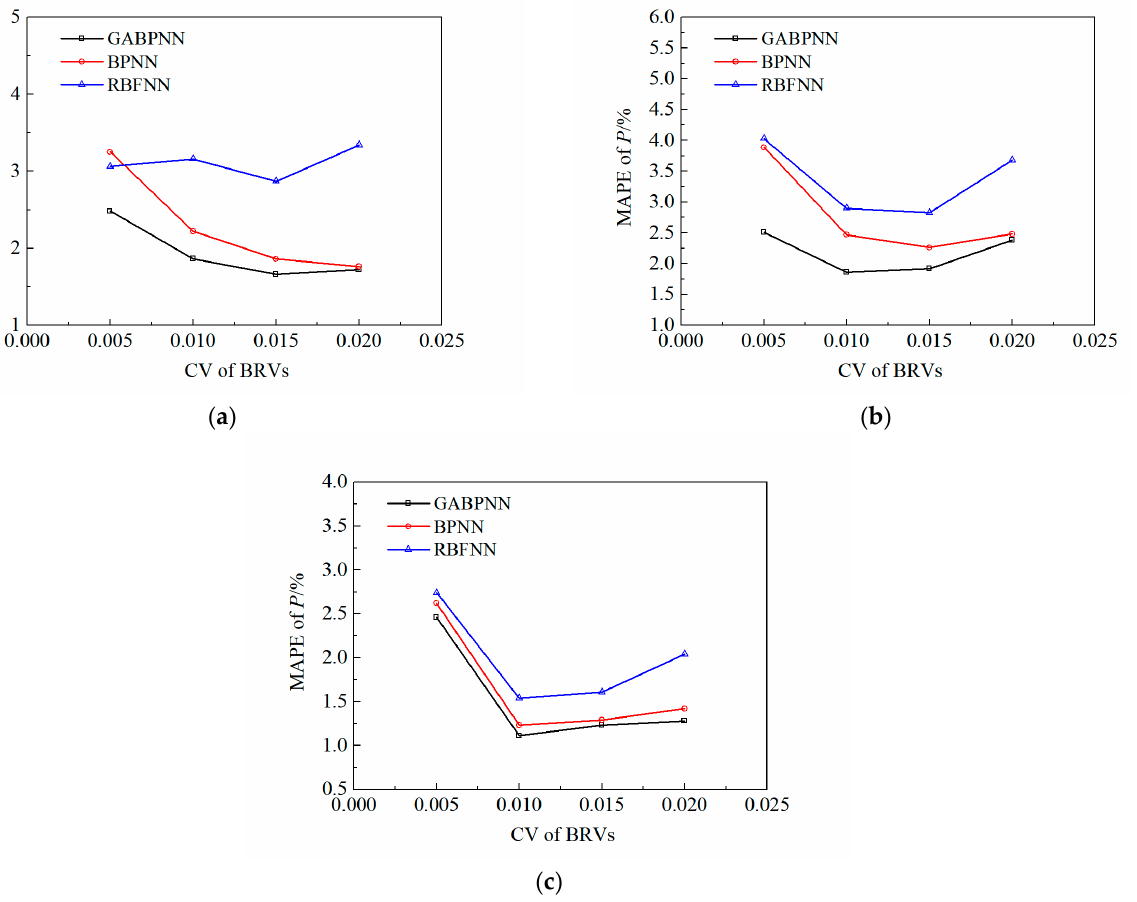
Figure 12. The comparisons of the MAPEs that the ANNs calculate the P ’s of the three gauges in the numerical mode in the DPR study under the shock load condition where v is 1000 m/s. ( a ) Gauge 1. ( b ) Gauge 2. ( c ) Gauge 3. (iv) Estimation of the statistical characteristics of P based on GABP-MCS